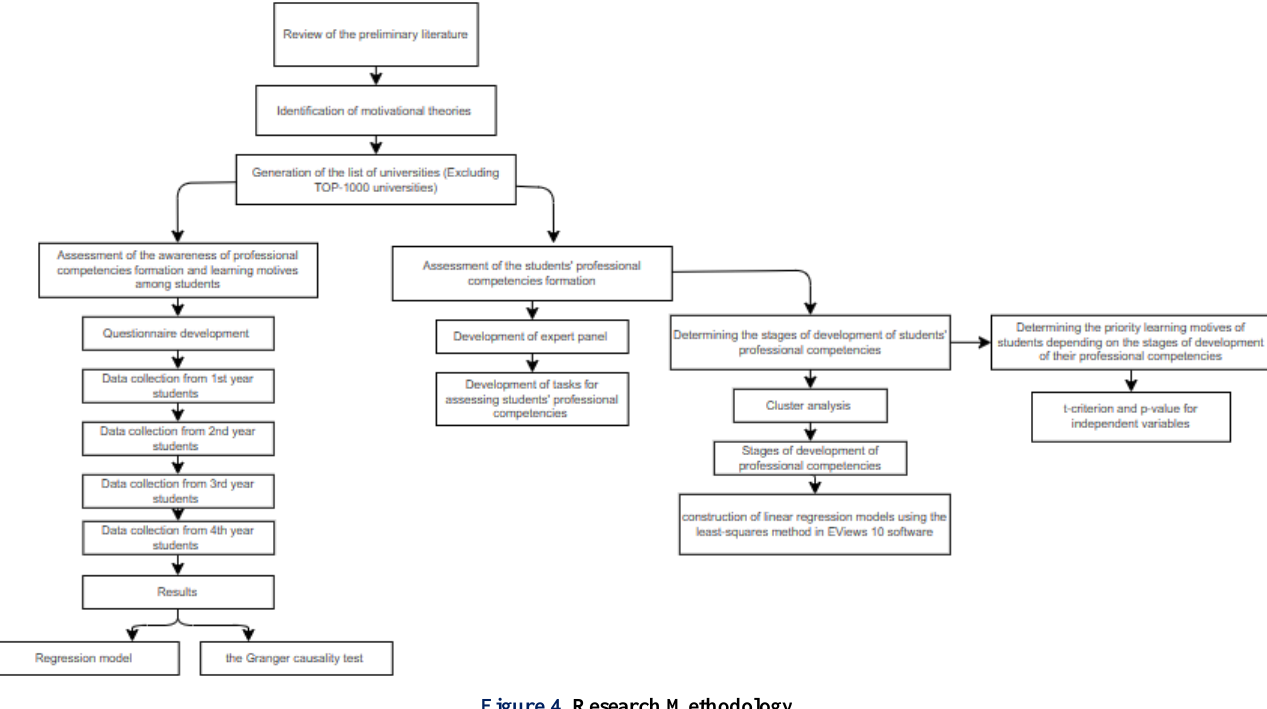
Figure 4. Research Methodology Table 1. Number of students at universities in Russia and Indonesia participating in the